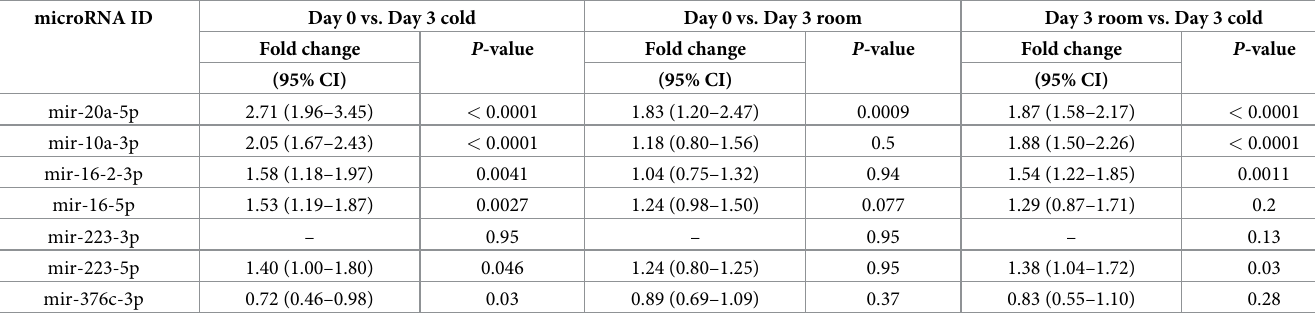
Table 2. Differentially expressed microRNAs in three-group comparison using